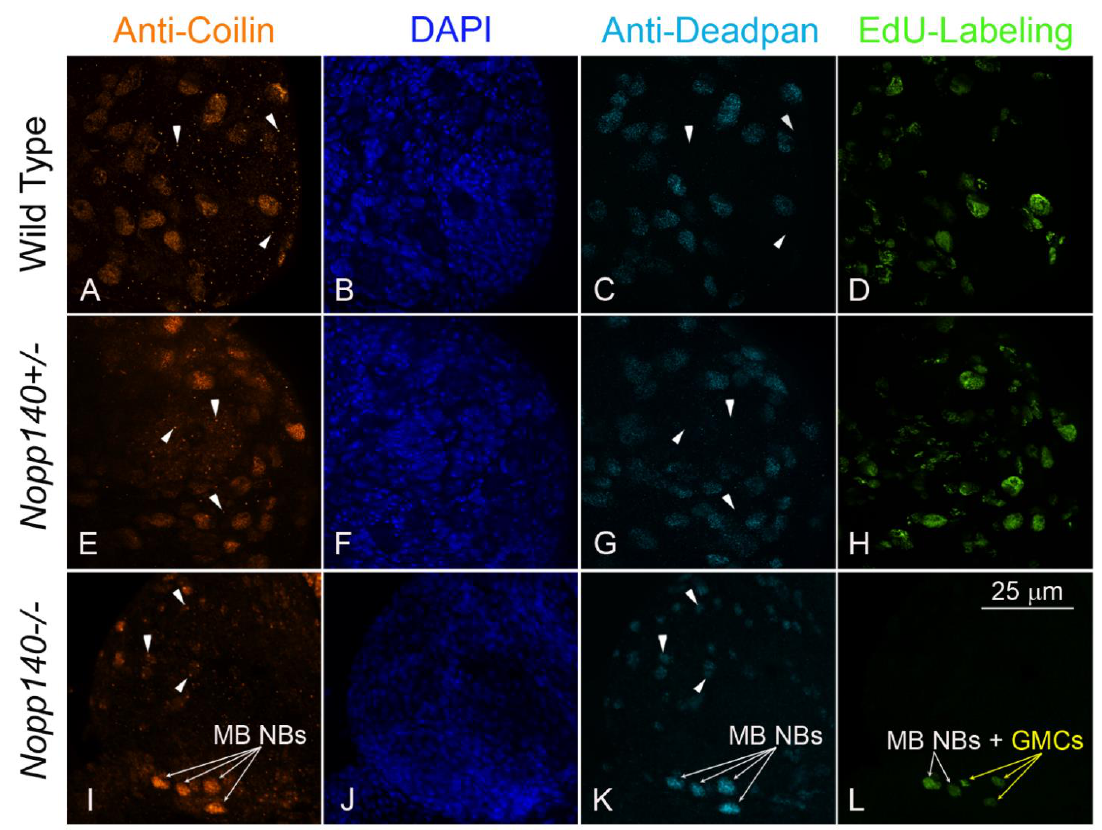
Figure 6. Mushroom body neuroblasts (MB NBs) displayed resilience amid nucleolar stress. In larval brains ( A , E , I ) anti- coilin labeled coilin within nuclei, ( B , F , J ) DAPI labeled nuclear DNA, ( C , G , K ) anti-Deadpan labeled nuclei of only the neuroblasts (NBs), and ( D , H , L ) a half hour pulse of EdU labeled S-phase cells. ( A , E ) In wild type and Nopp140+/- larval brains, coilin localized to Cajal bodies (CBs) in neurons (white arrow heads) but throughout the non-nucleolar nucleoplasm in NBs as identified by Deadpan labeling ( C,G ). S-phase NBs and ganglionic mother cells (GMCs) throughout the brain were EdU positive in both wild type ( D : w 1118 , n = 15) and Nopp140+/- ( H , n = 12) larvae. In the one J11 Nopp140-/- larval brain shown here ( L , n = 9), two of the four MB NBs (white arrows) and the MB lineage GMCs (yellow arrows) were labeled with EdU. ( K ) Anti-Deadpan labeled all four MB NBs (white arrows) and confirmed the identity of the EdU positive MB GMCs by their proximity to the MB NBs. ( I ) In the J11 Nopp140-/- brain, the MB NBs (white arrows) maintained a wide expanse of coilin throughout the non-nucleolar nucleoplasm, while other NBs had comparatively less nucleoplasmic coilin but showed now discernable CBs (white arrow heads). Bar = 25 µm for all images.